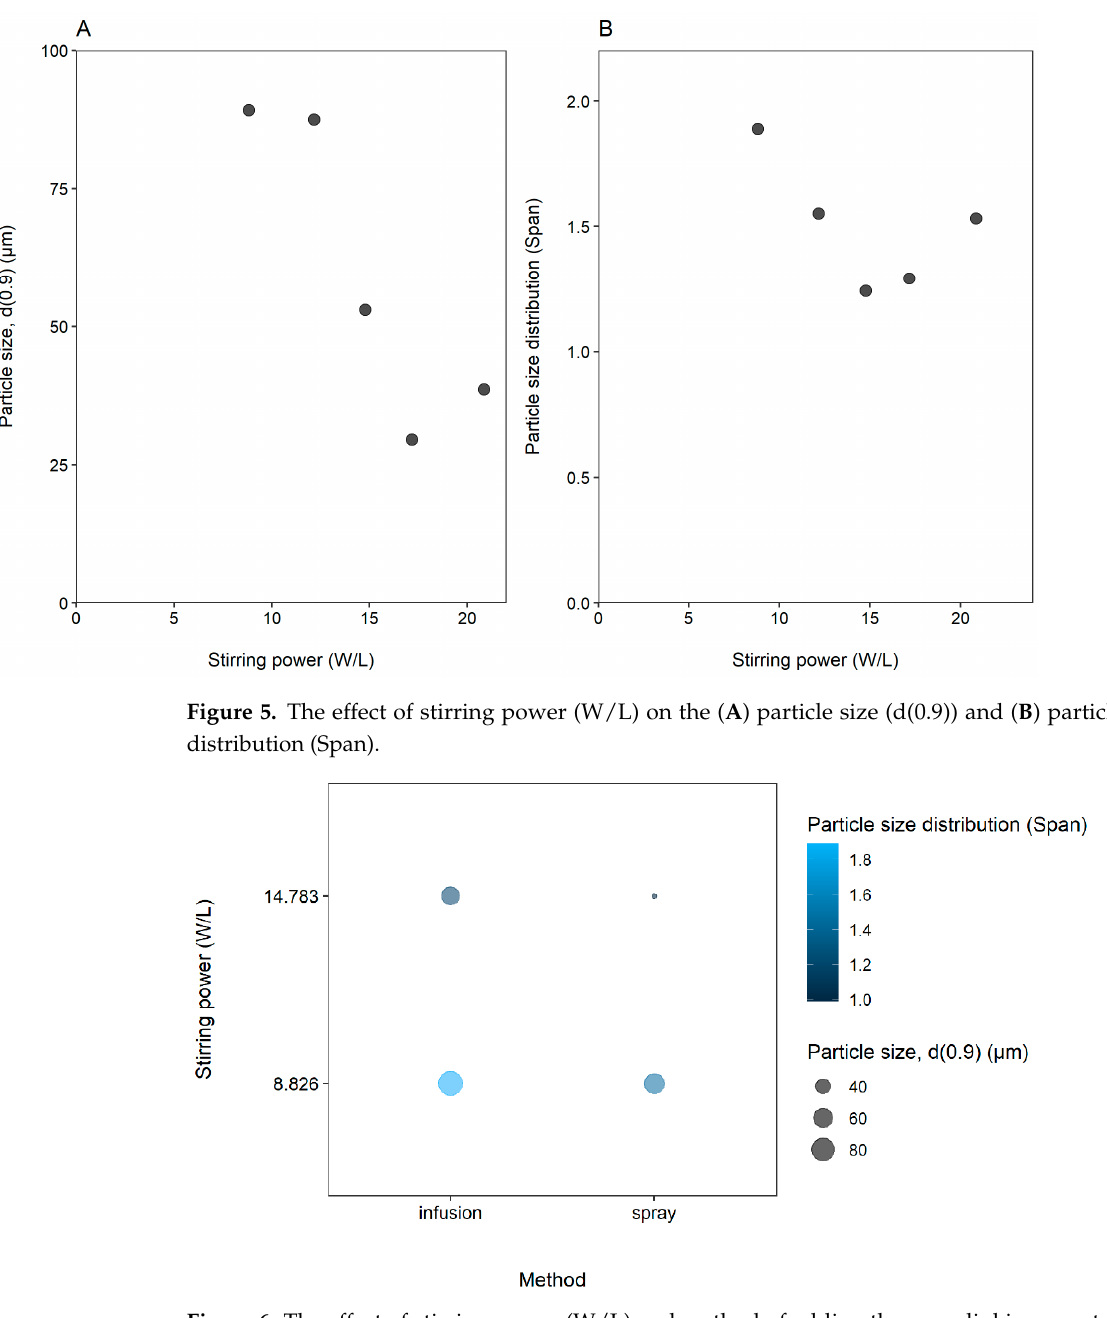
Figure 6. The effect of stirring power (W/L) and method of adding the cross-linking agent on the microparticle size as (d(0.9)) and microparticle size distribution (Span).